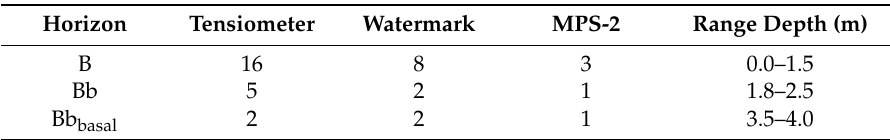
Table 1. Type and number of sensors installed in the pyroclastic fall soil horizons (except for the C horizon), and range